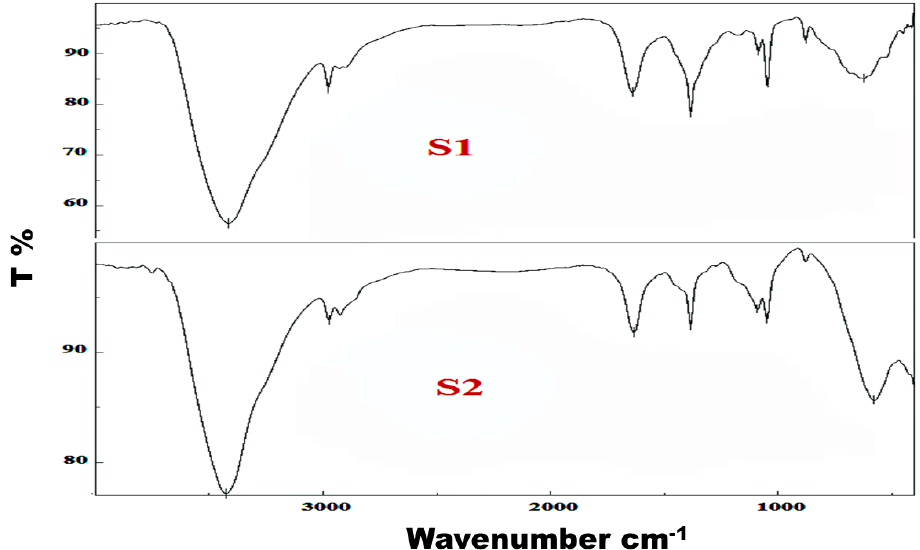
Figure 2. Fourier-transform infrared (FTIR) spectrum of S1 and S2